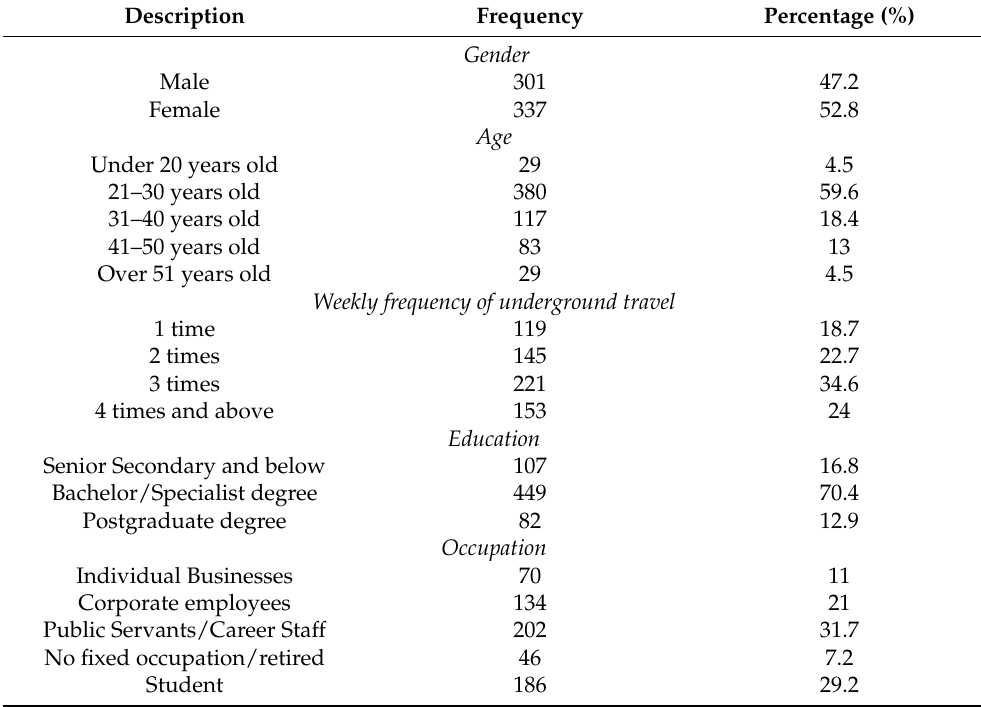
Table 2. Surveyed